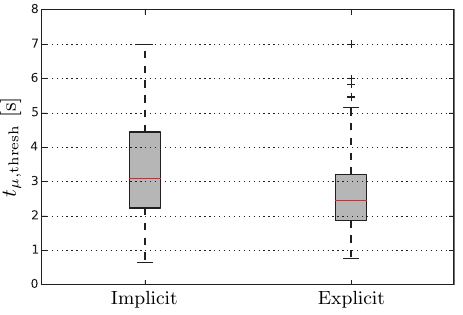
Figure 4: The plot shows the convergence time for the optimization methods, evaluated on the micro- for µ thresh = 2 . 5% , for 40 scopic model, with t µ thresh random graphs with M = 6 and random matrices Q with 4 species and 4 traits. The boxplots show the median and the 25th and 75th